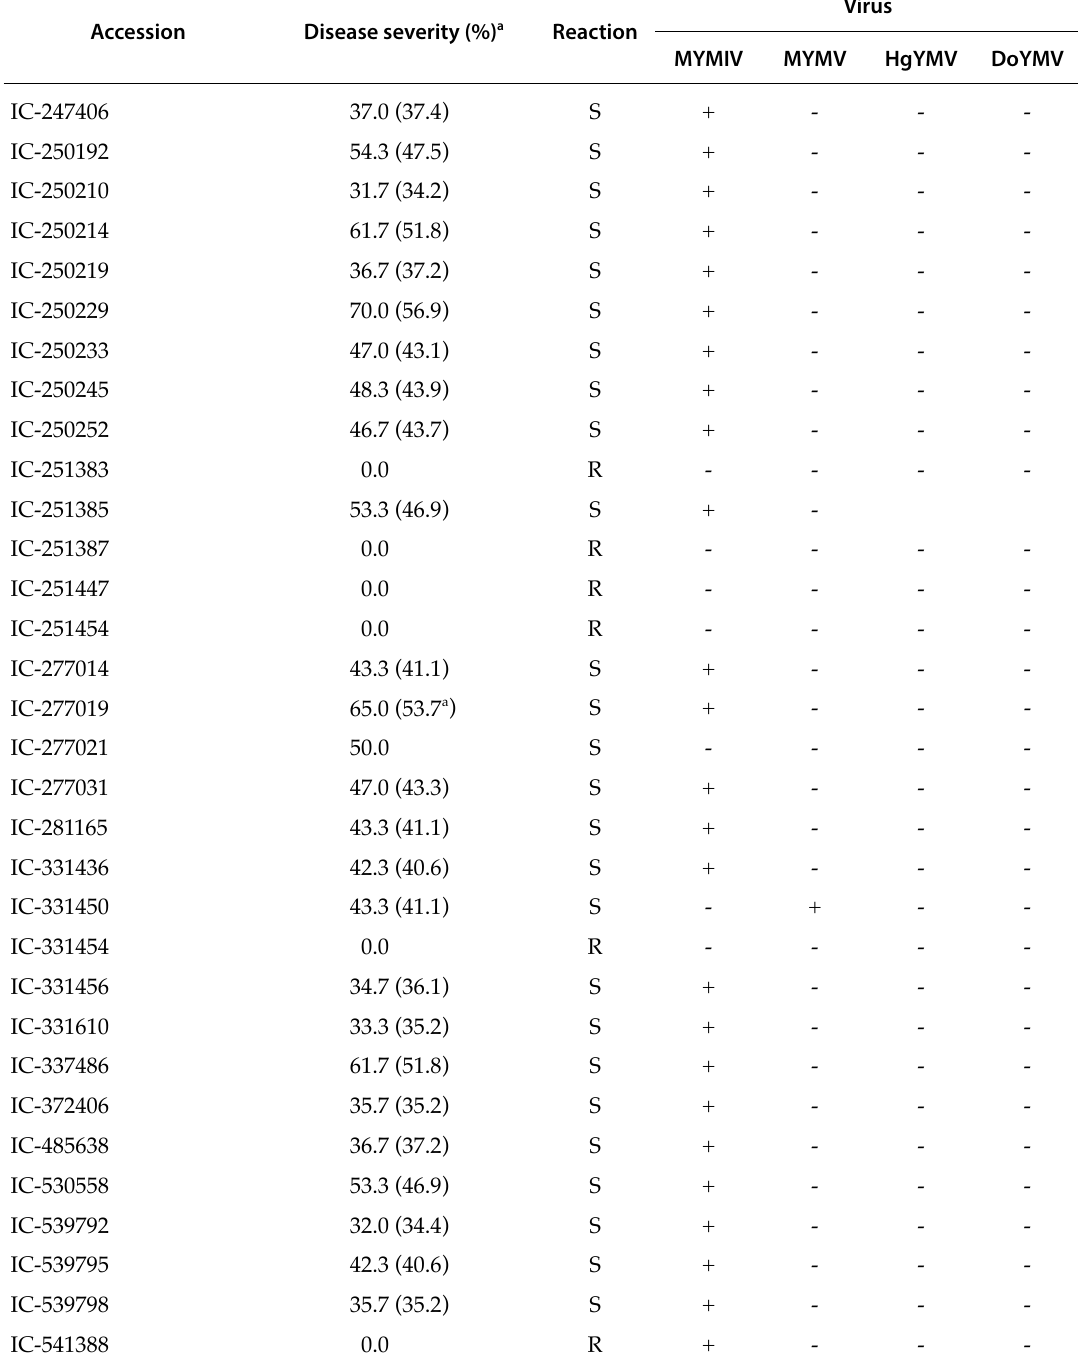
Table 3. Average disease severity and host reaction of wild Vigna species/sub-species accessions against yellow mosaic disease during crop seasons of 2012 and 2013, and PCR detection of